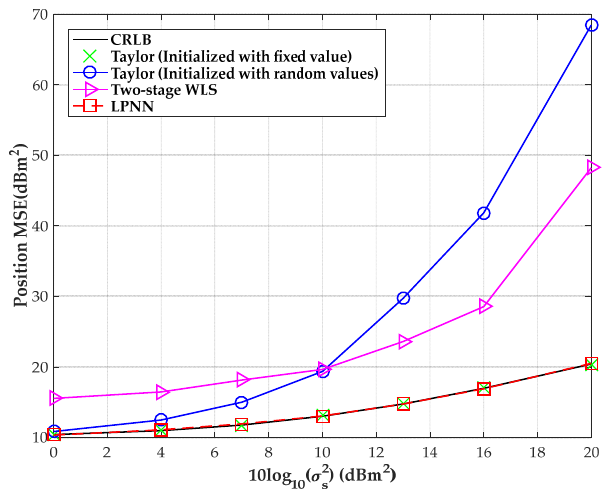
Figure 12. MSE versus level of sensor location error with the source position located at ( 300, − 280 ) m.